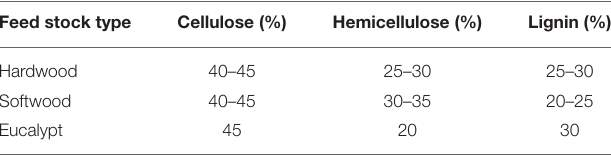
TABLE 8 | Chemical composition of different biopolymers of wood ( Papari and Hawboldt, 2015